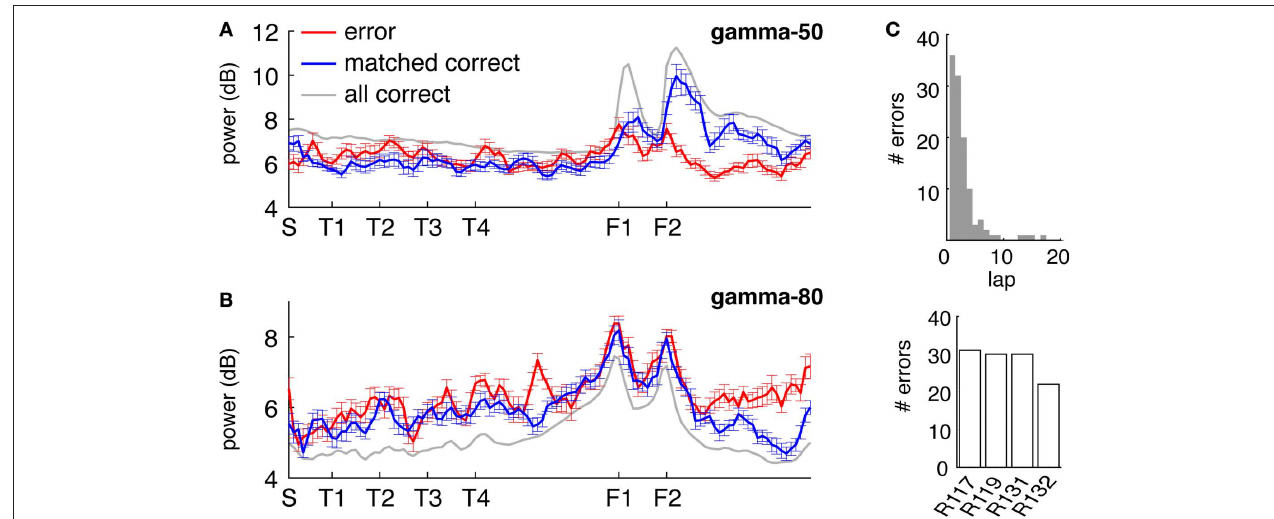
FIGURE 7 | The spatial distribution of gamma-50 power, but not gamma-80 power, is affected by the presence or absence of reward receipt at the reward sites. (A) Spatial distribution of gamma-50 power on error laps (red line, no reward received), matched correct laps (blue line, reward received) and all correct laps (grey line). Note the higher power at F2 on correct laps. (B) Spatial distribution of gamma-80 power; panel layout as in (A) . While gamma-80 power was increased elsewhere on the track, power at the reward sites was similar